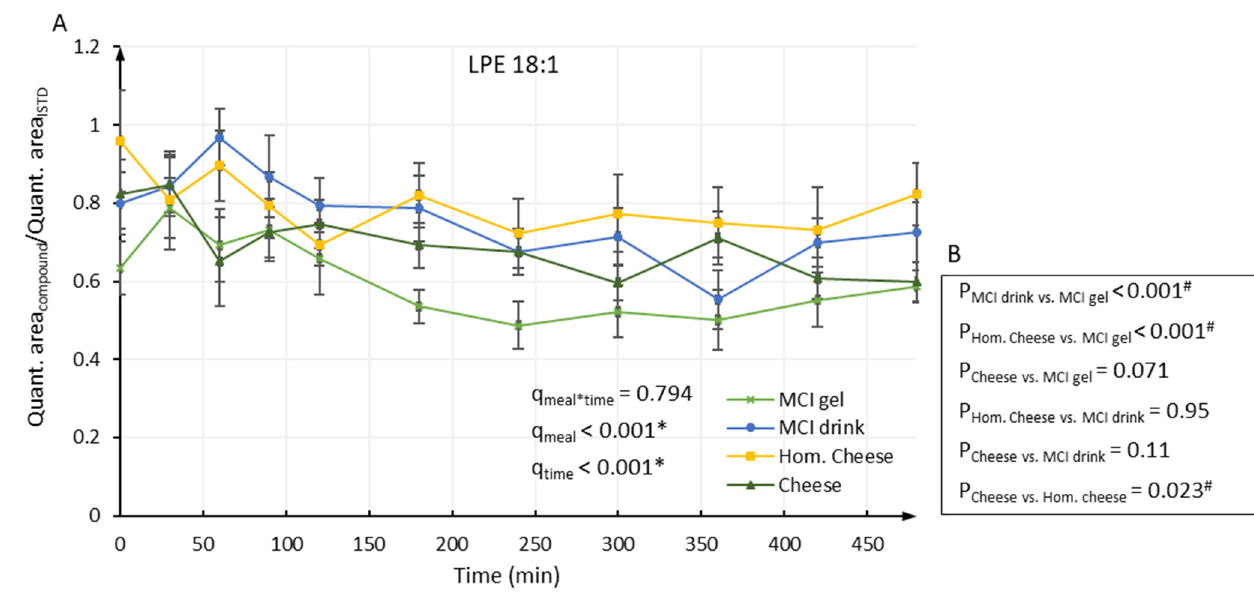
Figure 1. ( A ) Relative level of LPE 18:1 in plasma samples. Data were analyzed by repeated measures using a linear mixed model. Overall participant and within-visit participant differences were included as random factors and the analyses were adjusted for BMI, age and visit. q -values indicate FDR-adjusted p -values for meal–time interactions (q meal*time ), the effect of meal (q meal ) and the effect of time (q time ). * indicate significant differences ( q < 0.05). ( B ) p -values obtained from Tukey’s all-pairwise comparison conducted when a significant meal effect was observed in repeated measures analysis. # indicate significant differences ( p < 0.05).